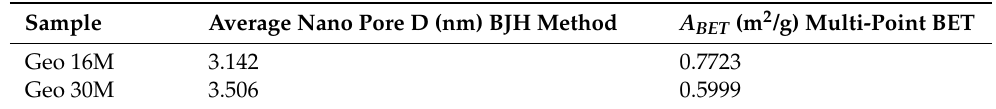
Table 3. BET characterization of Geo 16M and Geo 30M.